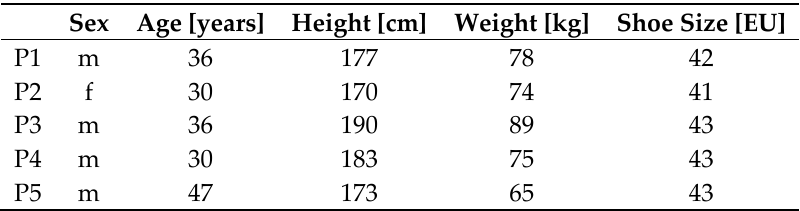
Table 1. Participant characteristics.